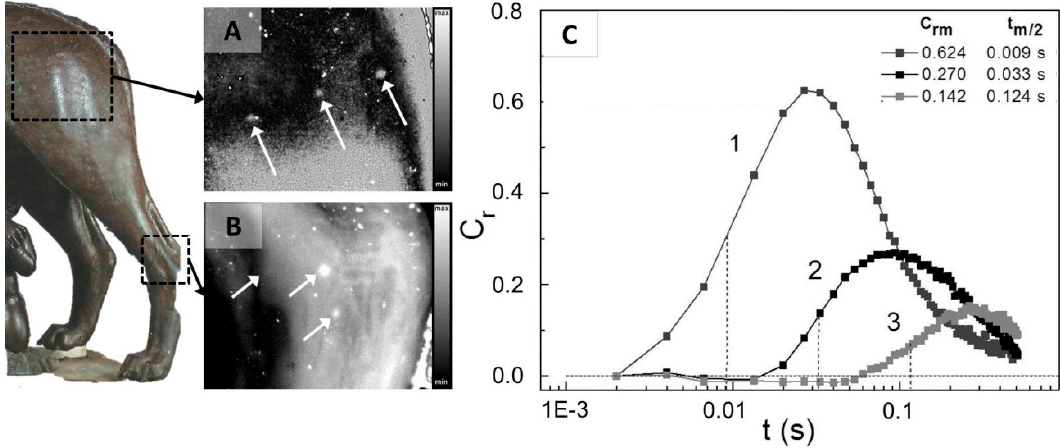
Figure 6. She Wolf, left rear paw. Thermograms ( A , B ) obtained by the front face heating mode where the arrows indicate some pseudo-spherical cavities; ( C ) time dependence of the contrast coefficients obtained over the cavities of Figure 6B. The vertical dashed lines intercept the t m/2 values (see text) for the various curves [48,49].